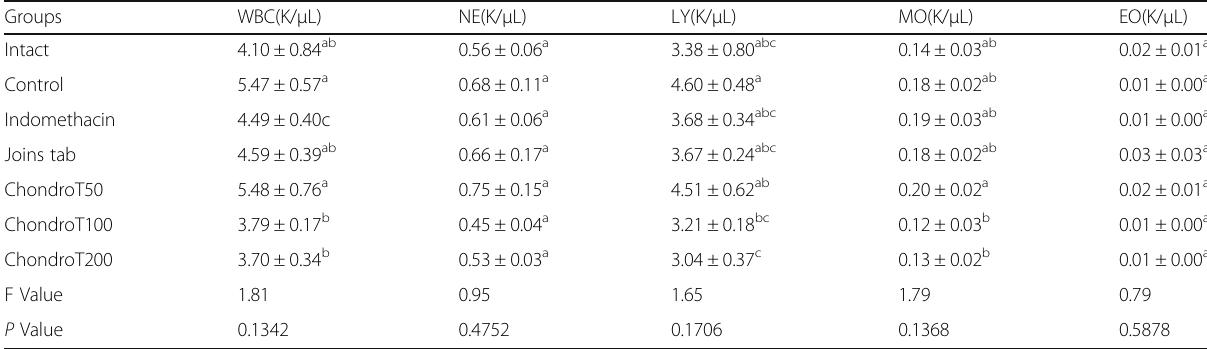
Table 4 Changes in the blood WBC, neutrophils, lymphocytes, monocytes, and eosinophils contents after ChondroT administration in collagenase-induced arthritis rats Groups